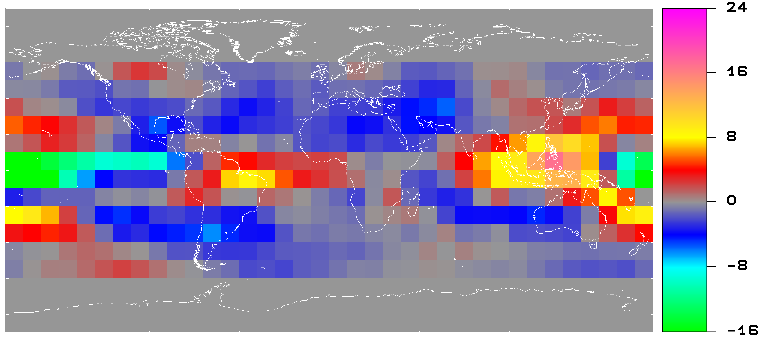
Figure 10. ERBS WFOV Outgoing Longwave Radiation variability between El Nino years and La Nina